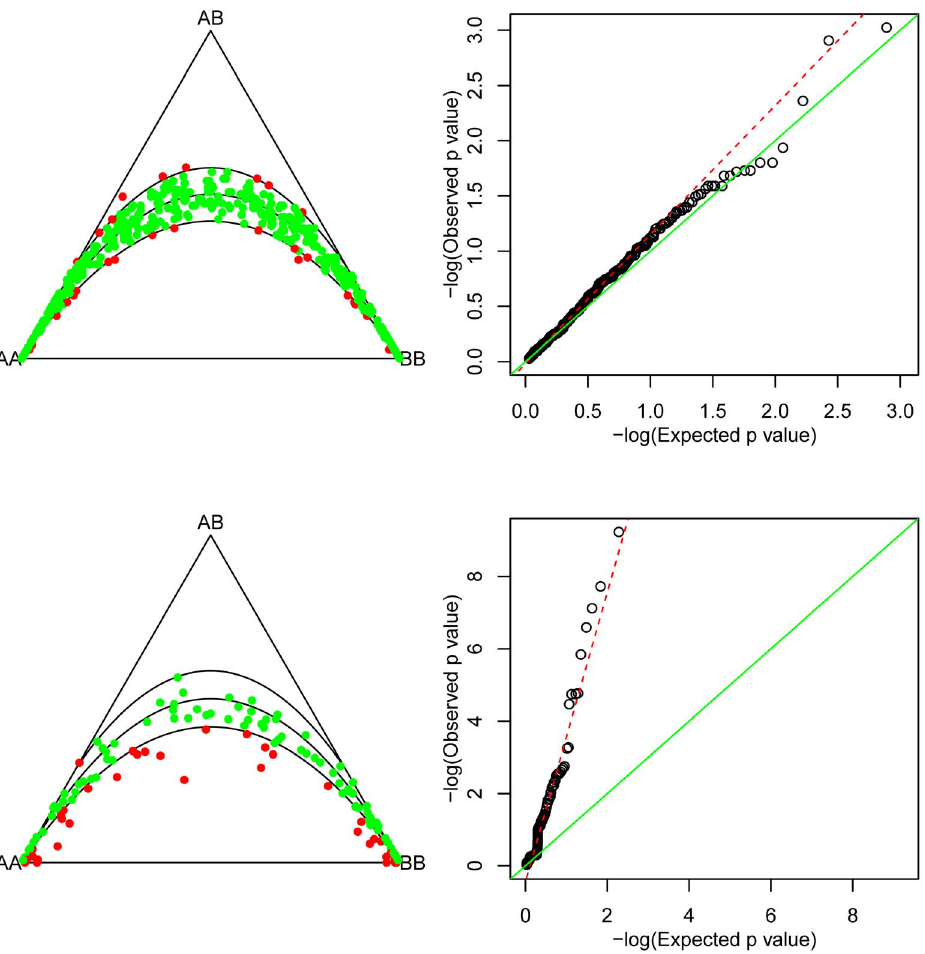
Figure 2. Ternary plots and Q-Q plots for Hardy-Weinberg proportions. Curves in the ternary plots indicate the HW parabola, and the limits of the 95% acceptance region of a x 2 test for HWP. Top row plots are for 545 fully observed SNPs. Bottom row plots are for 140 SNPs with 10 to 50% missings (missings were discarded in these plots). The Q-Q plots show two lines, a solid y ~ x reference line and an estimate of the linear tendency in the cloud of points (dashed).